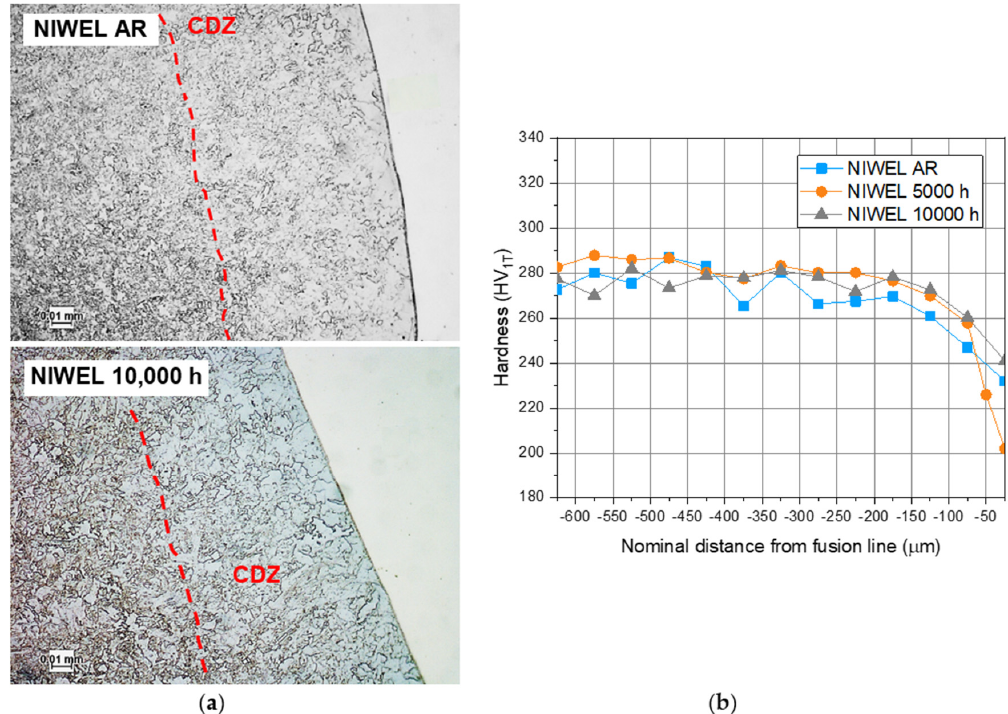
Figure 9. ( a ) Optical images of the SA 508 / Alloy 52 weld metal interface in NIWEL AR and NIWEL 10,000 h, with ( b ) the corresponding hardness profiles, showing the CDZ resulting from PWHT and no influence of thermal ageing.